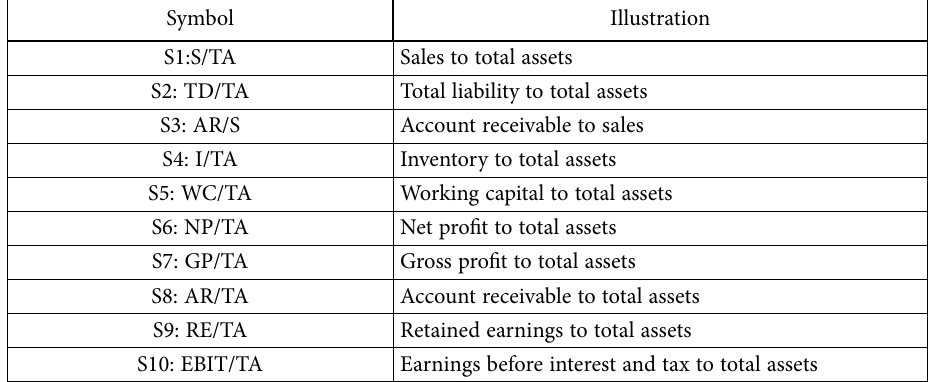
Table 3. The independent